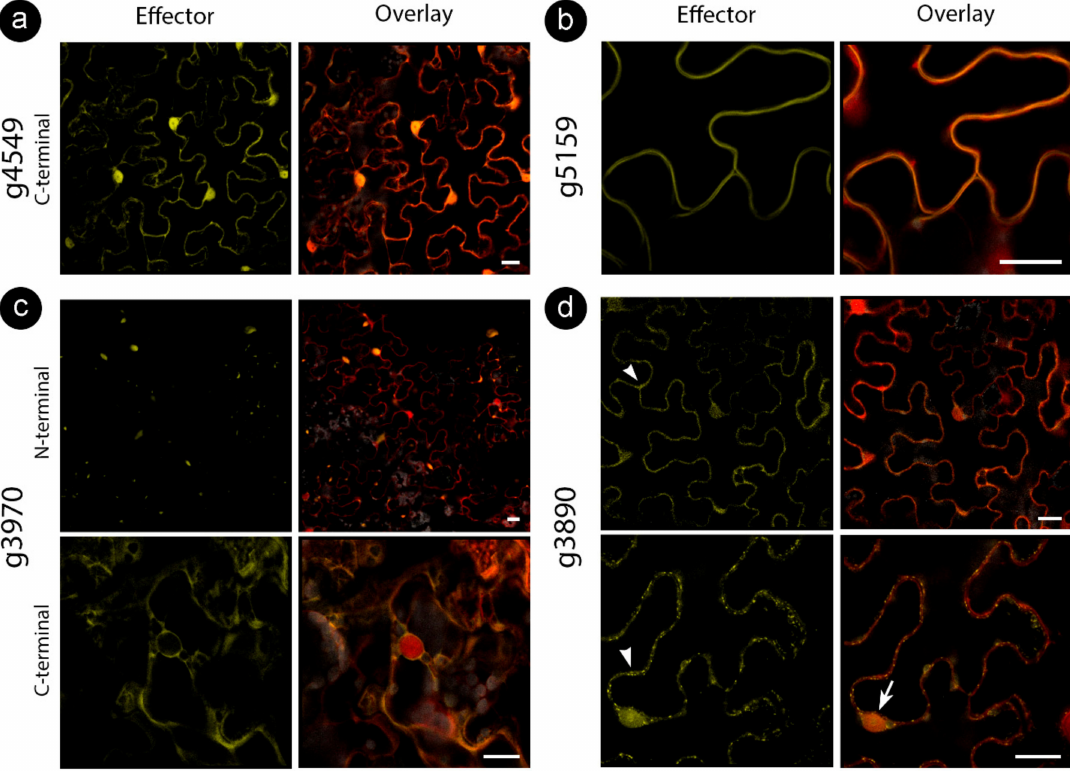
Figure 2. Sporisorium scitamineum candidate e ff ector proteins accumulate in di ff erent subcellular compartments. All fusion proteins were co-infiltrated with free RFP to help detect cytoplasm and nucleus. N -terminal denotes the presence of an N -terminal YFP tag, and C -terminal denotes the C -terminal citrine fusion. Representation of ( a ) stable nucleocytoplasmic, ( b ) cell wall, ( c ) aggregations (upper panel) and cytoplasmic (lower panel), ( d ) cytoplasmic with vesicles (arrowhead in the upper panel), nucleolar (arrow in the lower panel) and mitochondrial (arrowhead in the lower panel) localizations. Bars: 20 µ